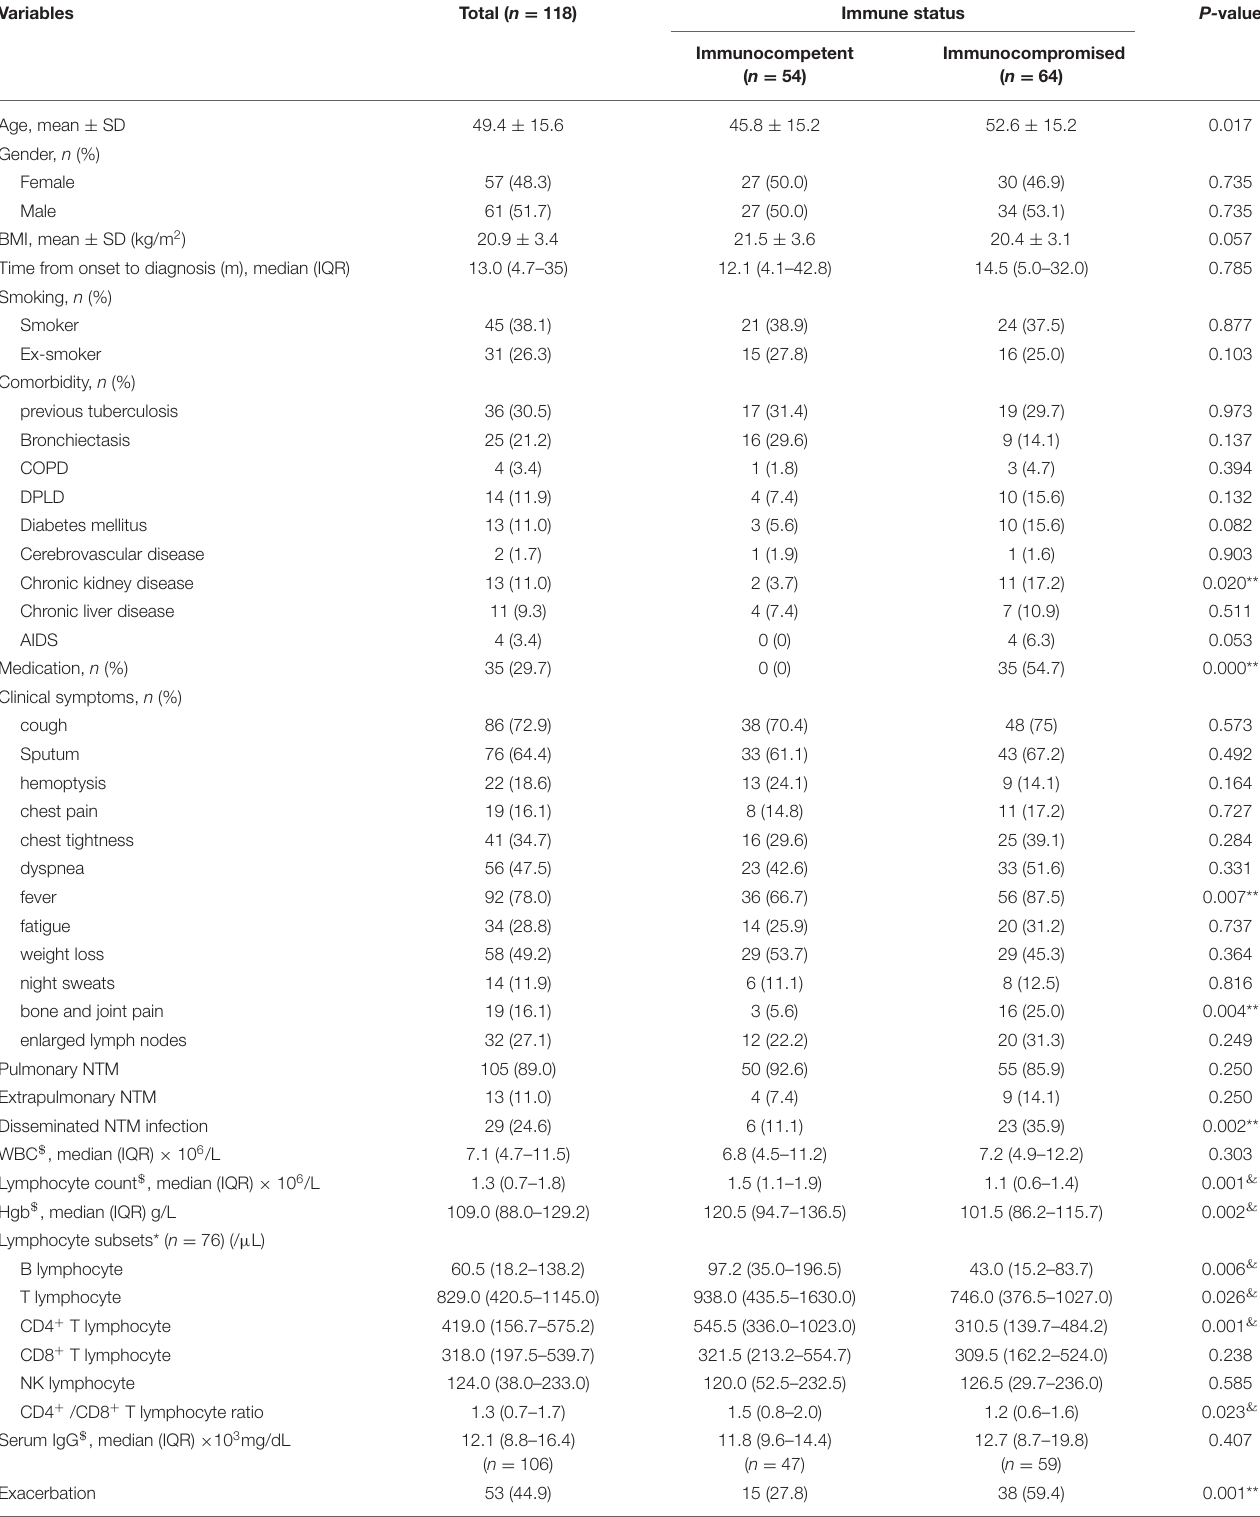
TABLE 2 | Comparison of characteristics and clinical manifestations between immunocompetent and immunocompromised patients with NTM